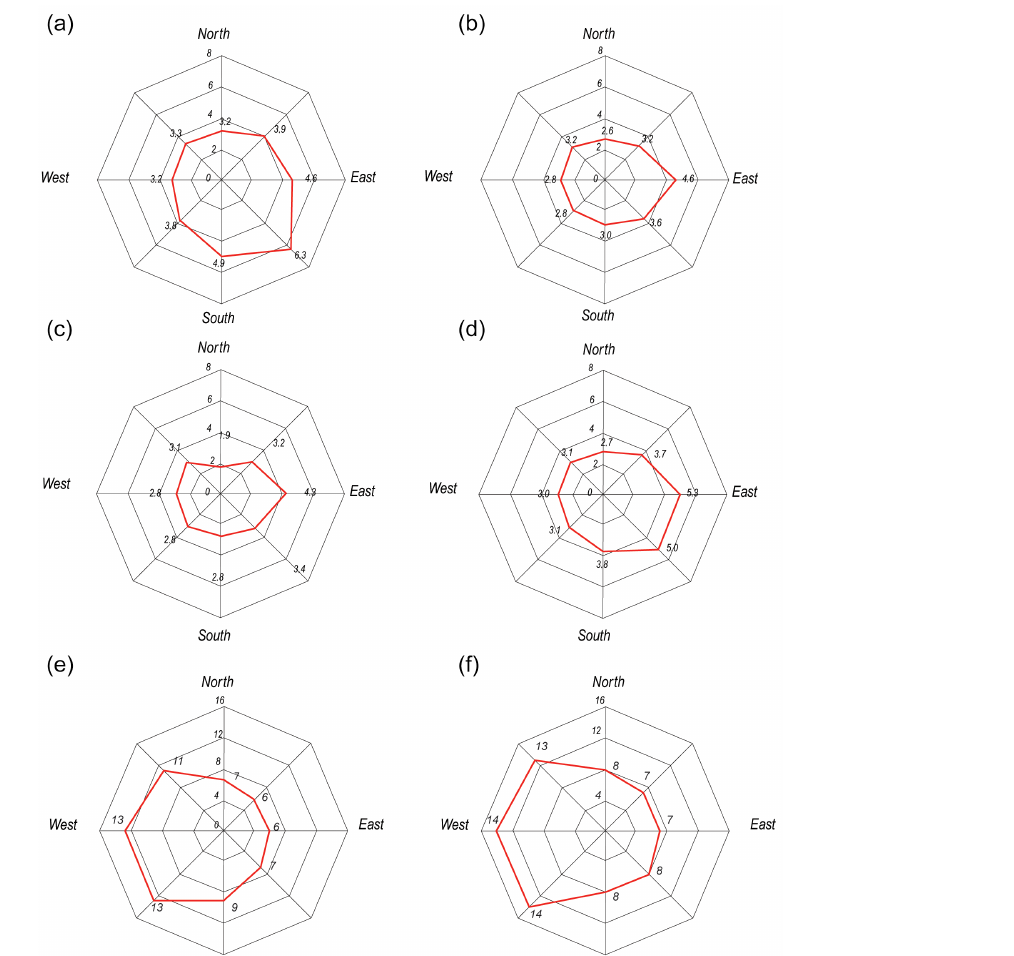
Figure 5. Multiannual average wind speed registered at meteorological stations in Nida, Šilut˙e and Klaip˙eda: (a) December–February (Nida); (b) March–May (Nida); (c) June–August (Nida); (d) September–November (Nida); (e) multiannual maximum wind speed (Šilut˙e); (f) multiannual maximum wind speed